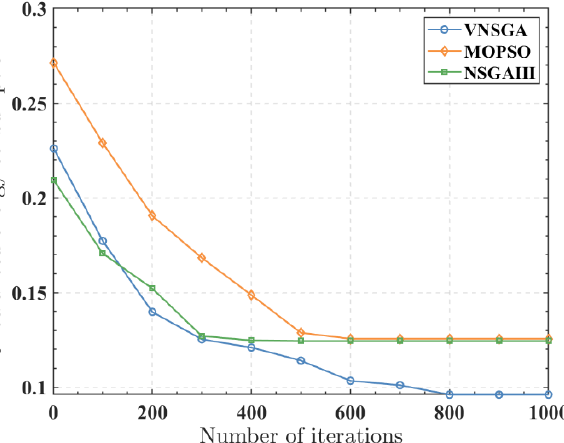
Figure 13. Unbalanced energy consumption for three algorithms from different iterations for 50 m R smax and 100 m R cmax with respect to area A. Figure 14. Unbalanced energy consumption for three algorithms from different iterations for 75 m R smax and 150 m R cmax with respect to area A.